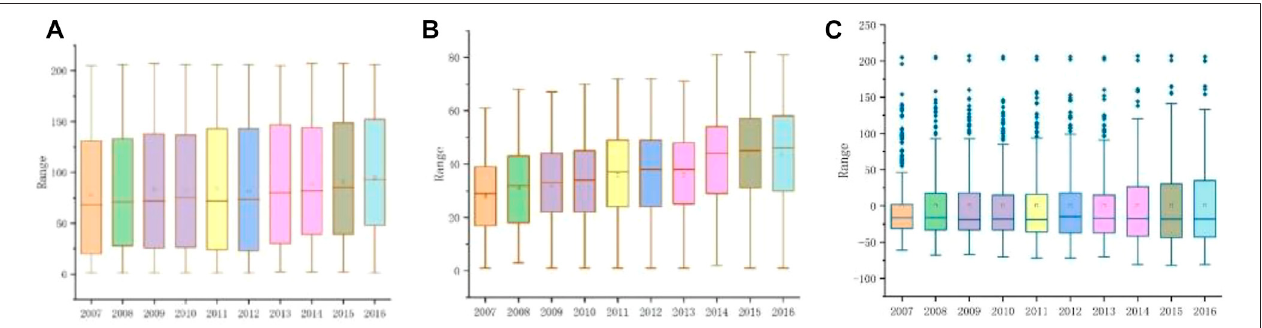
FIGURE3 | Basic properties ofnetwork diagrams from 2007to 2016: (A) Boxplot ofthe unweighted indegree network. (B) Box plot ofthe unweighted outdegree network. (C) Box plot of the unweighted indegree minus outdegree network.